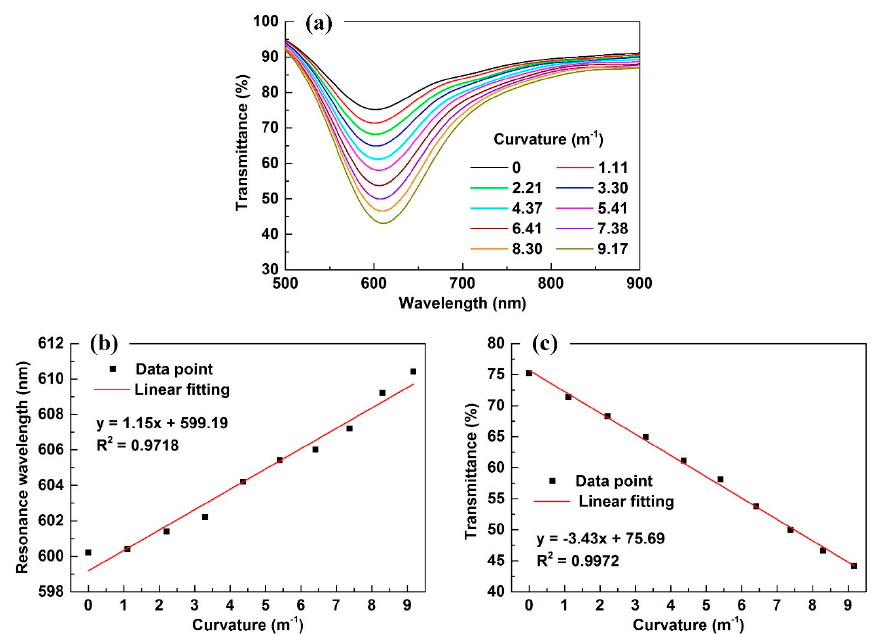
Figure 5. ( a ) The transmitted spectra under a series of curvatures; ( b ) the resonance wavelength as a function of curvature; ( c ) the transmittance as the function of